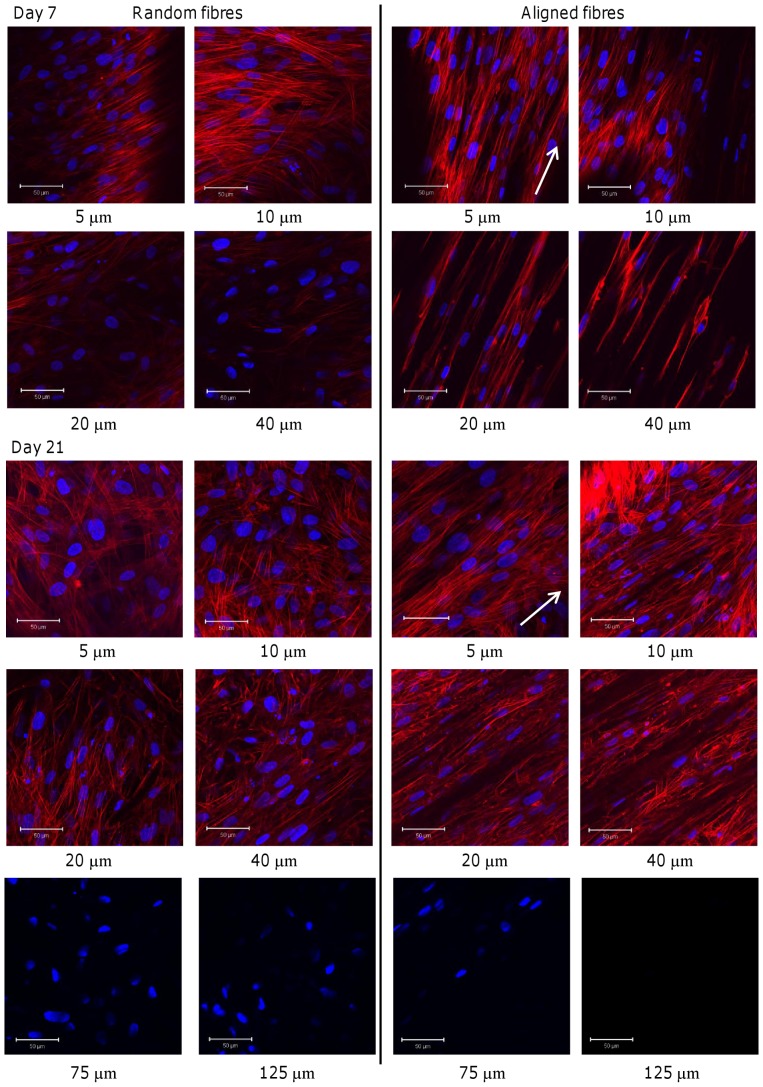
HDF morphology on PCL fibres.Nucleus (DAPI in blue) and cytoskeleton (phalloidin-TRITC in red) of HDFs seeded on random and aligned scaffolds. HDF morphology was visualised at day 7 (top) and 21 (bottom) imaged at different depths (5–40 µm). Cells on random fibres were generally attached in multiple directions while cells on aligned fibres were spindle shaped and aligned in the fibre direction. White arrows indicate direction of scaffold fibre alignment. Scale bars are 50 µm.